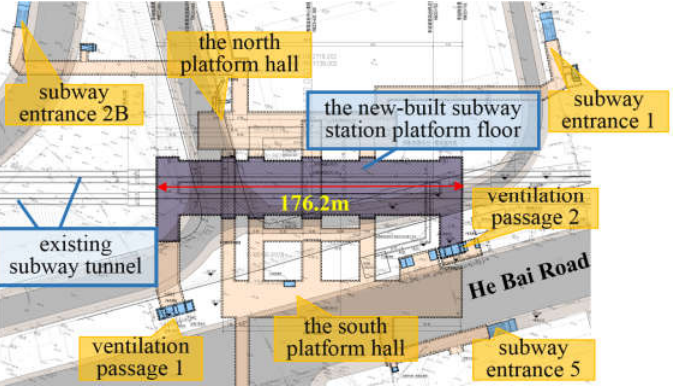
Figure 1. The plan of subway tunnel in situ expansion excavation to a subway station.